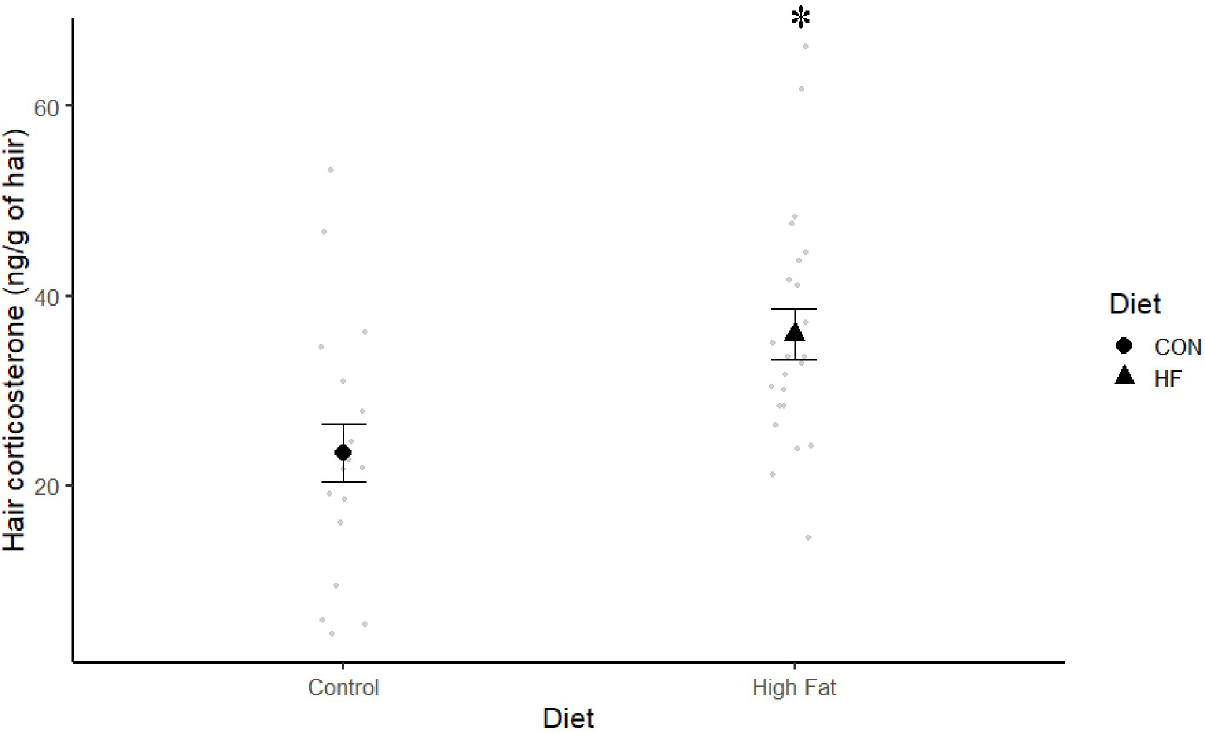
Fig 3. Effect of diet on hair corticosterone levels in mice from cohort one between CON (n = 18) and HF (n = 23). � indicates significant results (P < 0.05).